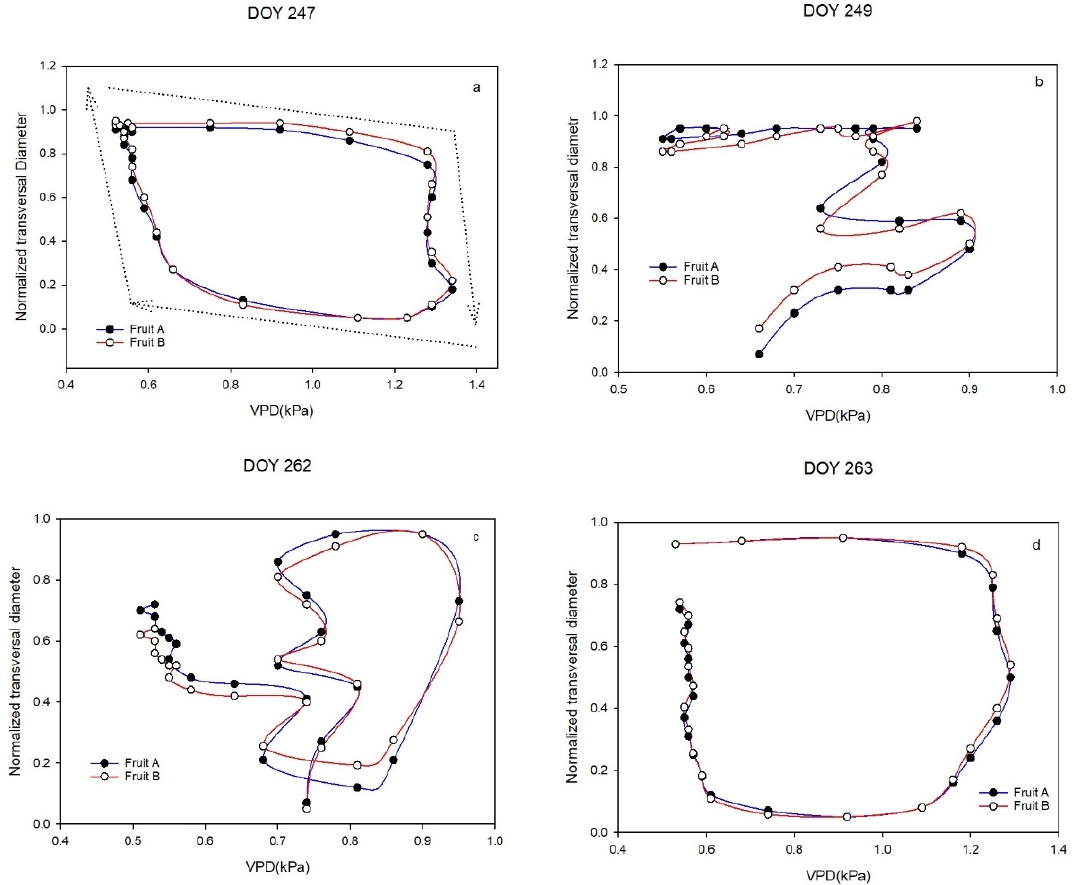
Figure 6. Correlation between transversal diameter and VPD for fruit A and B in four example days of the first period of the experiment: ( a ) complete clockwise hysteresis curve; ( b ) no noticeable model of hysteresis curve; ( c ) partial clockwise hysteresis curve; ( d ) incomplete clockwise hysteresis curve.